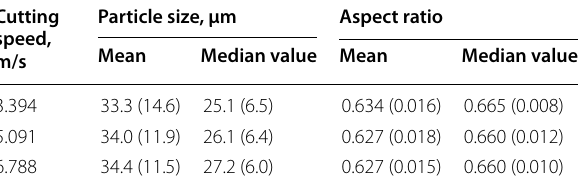
Table 2 The mean and median value of particle size and aspect ratio from all sampling points at three cutting speeds Cutting